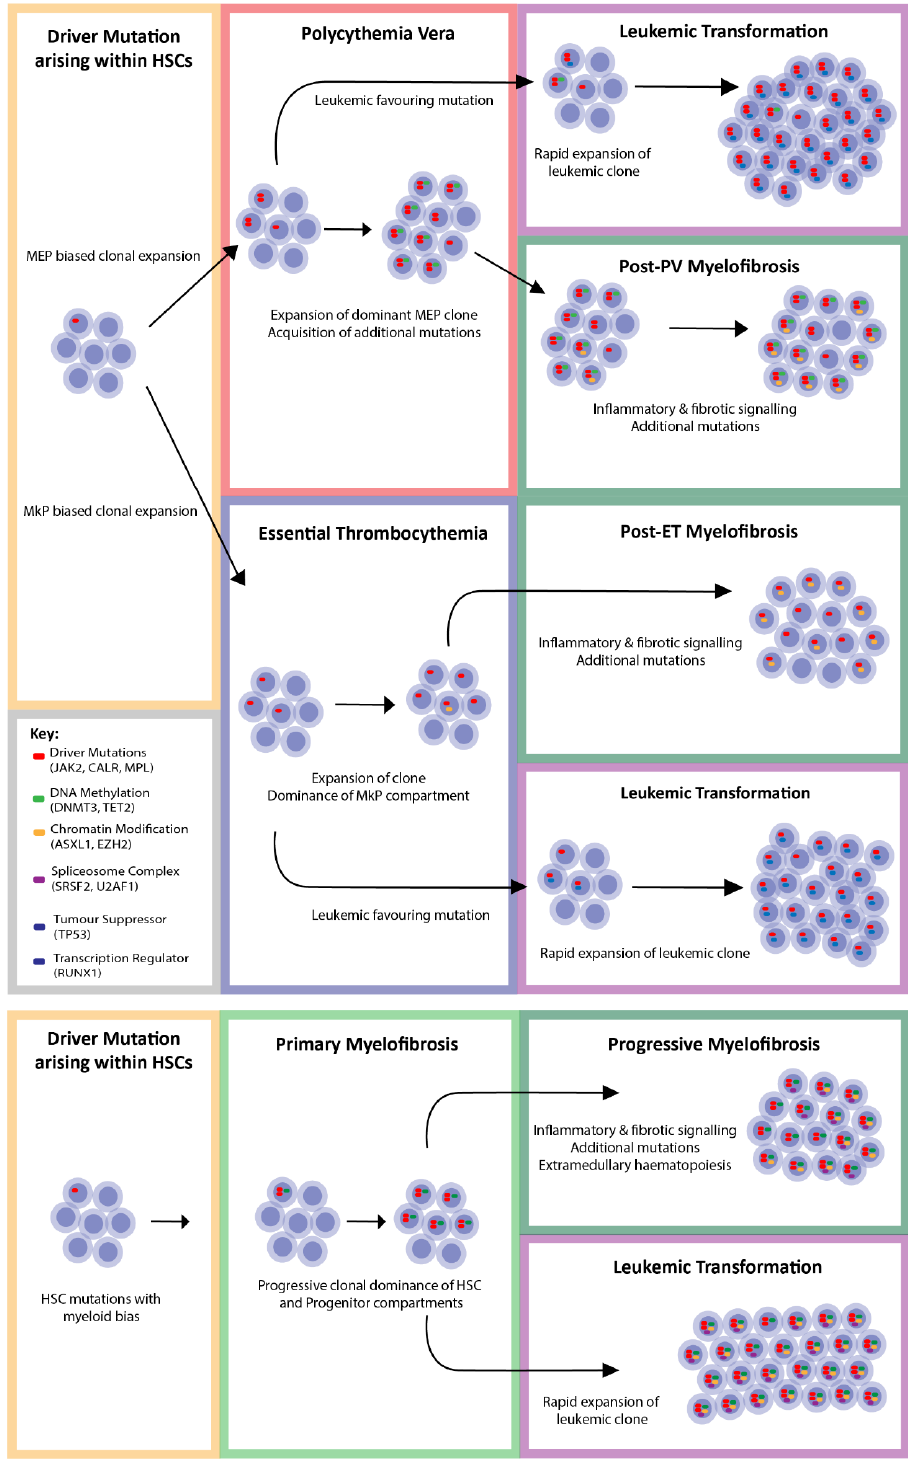
Figure 3. A proposed model for clonal evolution in MPN with acquisition of additional mutations leading to disease progression.